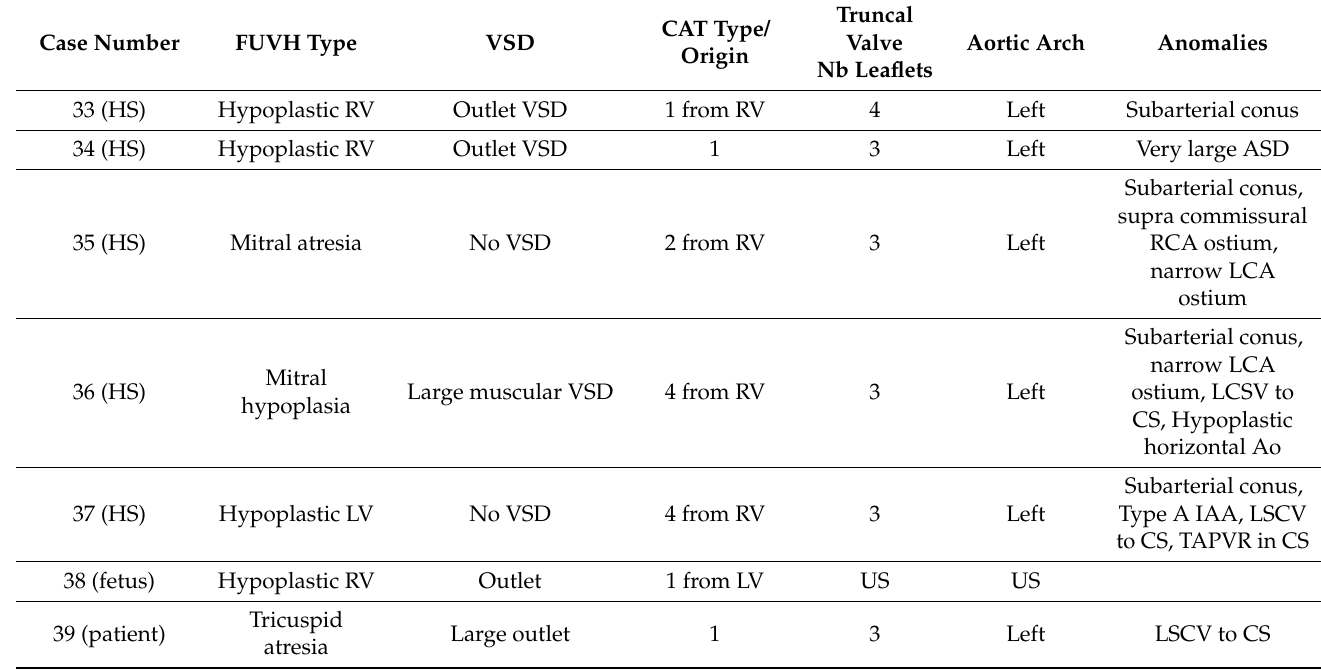
Table 2. Anatomic characteristics of cases 33 to